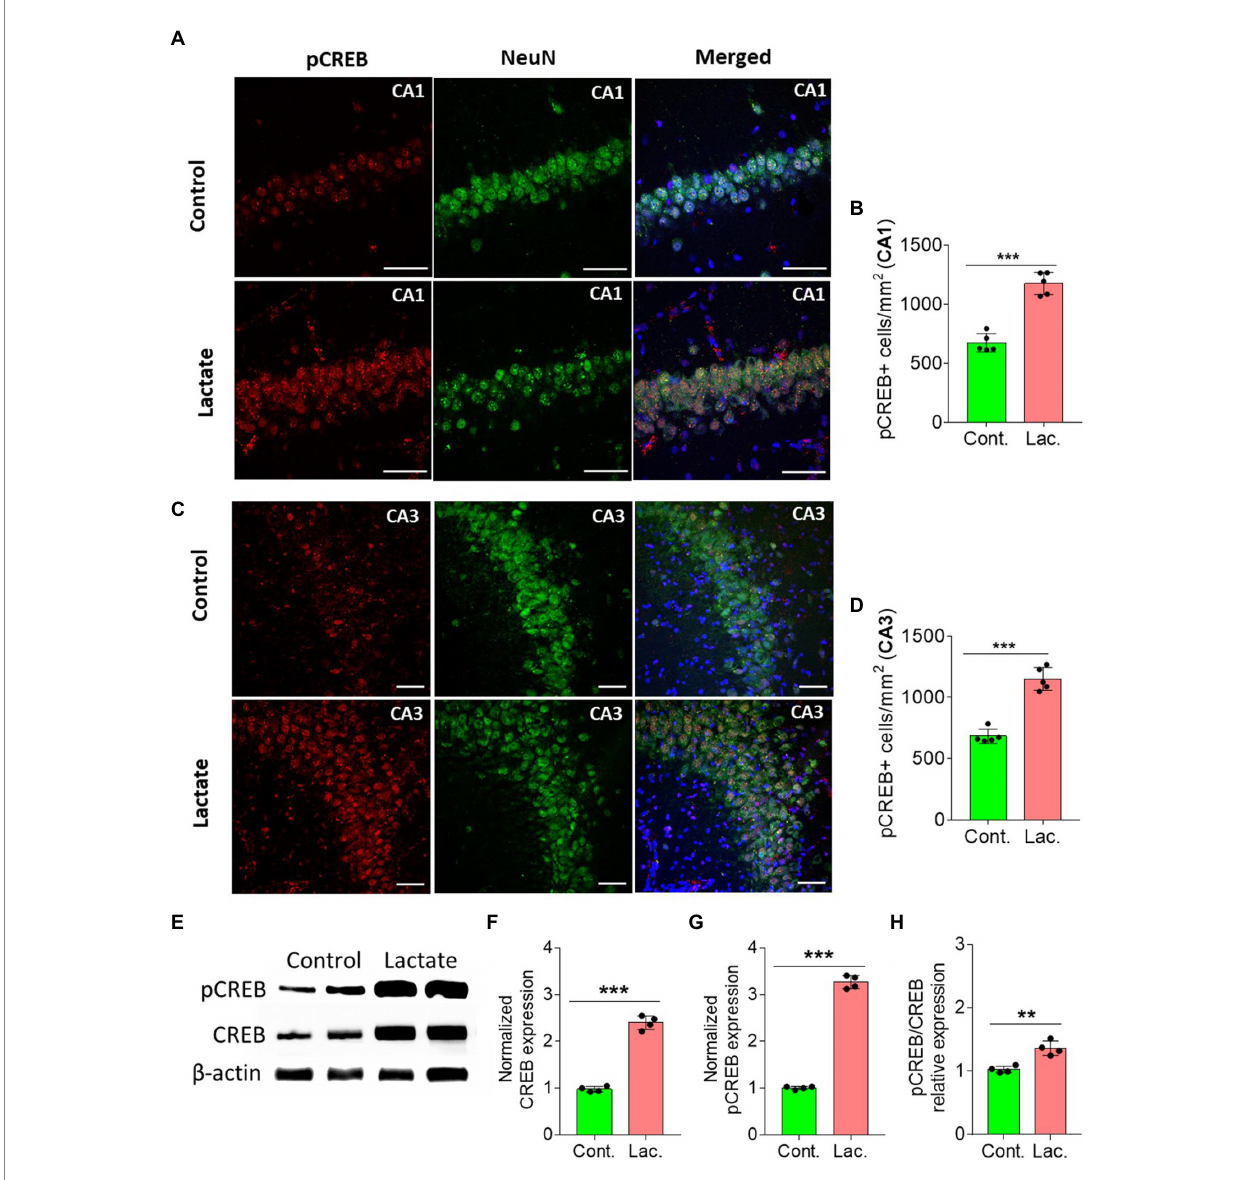
FIGURE 3 L-lactate increases CREB, pCREB, and pCREB/CREB in HPC. (A,C) Representative confocal micrograph of pCREB (red) co-labelled with NeuN (green) in the CA1 (A) and CA3 (C) areas of HPC of control and lactate groups. L-lactate infusion increased pCREB in both areas of HPC. Scale bars: 20 μ m. (B,D) Number of pCREB+ cells in CA1 (B) and CA3 (D) areas of HPC of control and lactate groups. Data are shown as mean ± SD ( n = 5 rats per group). p *** < 0.001, unpaired Student’s t -test. (E–H) . Representative WB images of pCREB and CREB in the HPC extracts from control and lactate groups. Intensity of pCREB and CREB was quantified and normalized with β -actin and was found to be significantly increased in lactate group compared to control (F,G) . pCREB/CREB ratio was also increased (H) . Data are shown as mean ± SD ( n = 4 rats per group). p *** < 0.001, p** < 0.01, unpaired Student’s t